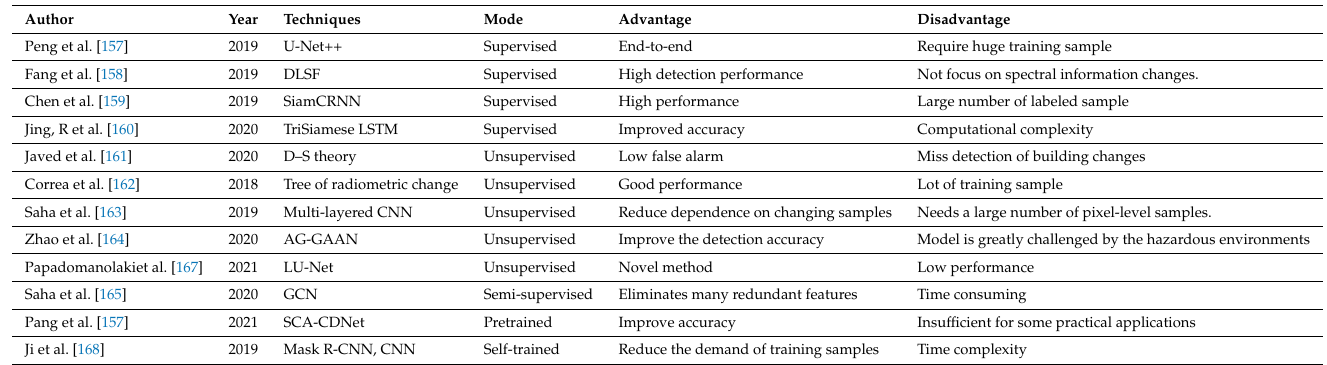
Table 12. Summary of the literature work of change detection techniques based on the VHR im- age